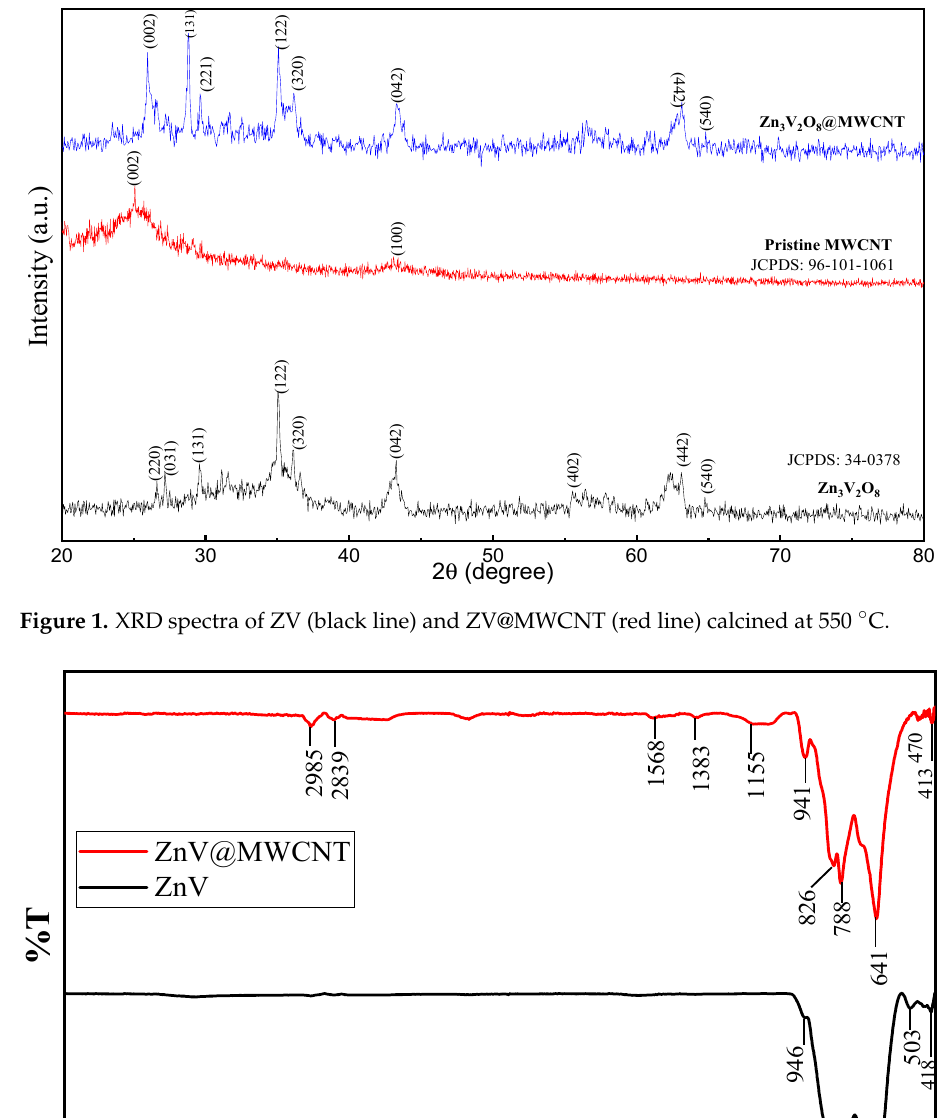
synthesized compounds are calcined as 550 °C, there is no peak of absorbed water (–OH).